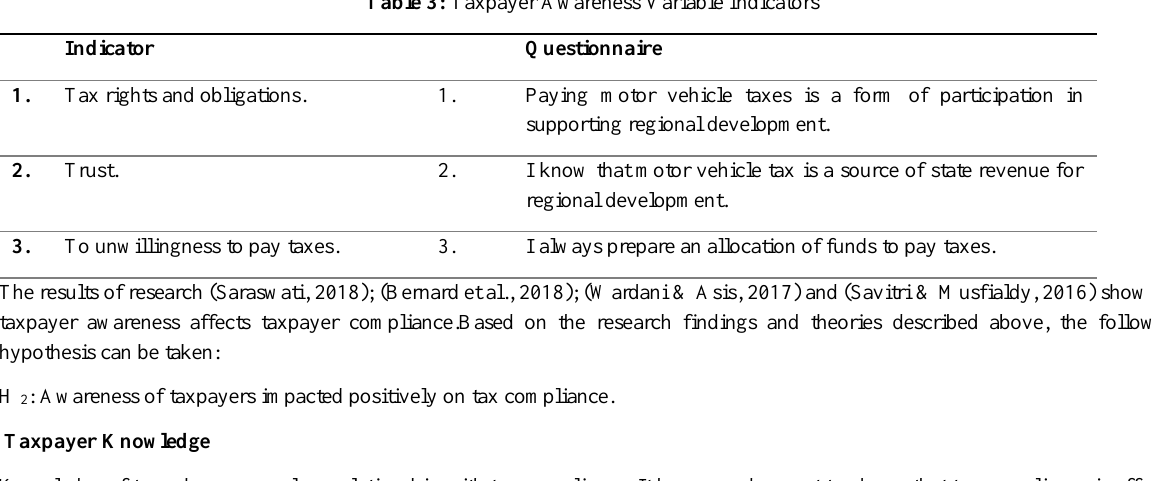
Table 3: Taxpayer Awareness Variable